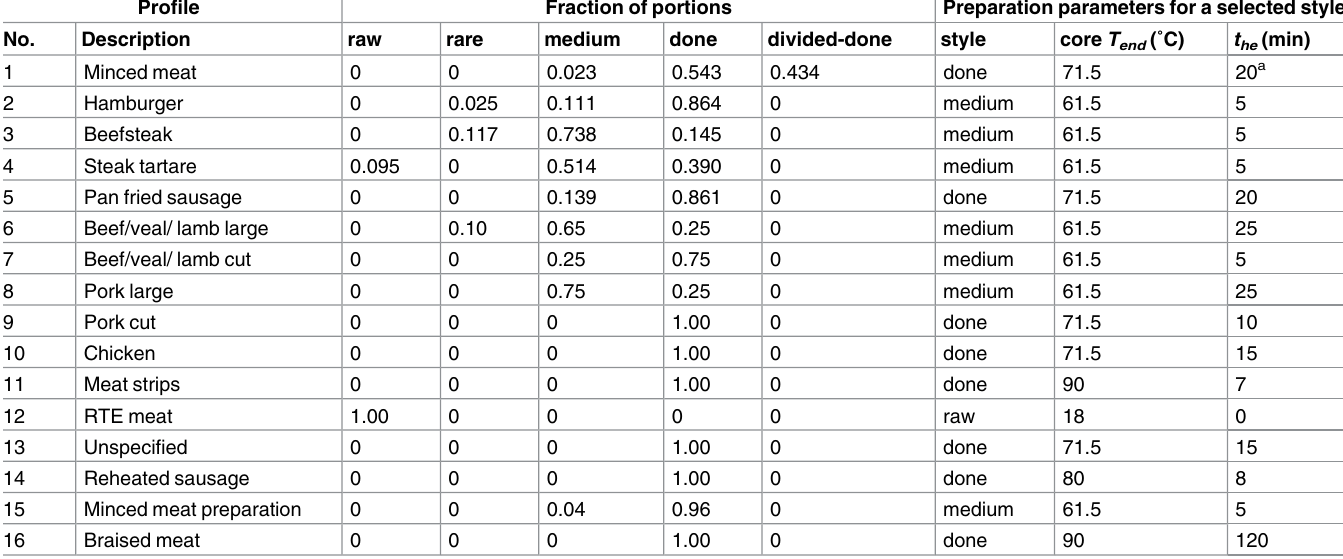
Table 6. Heating profiles for food products at the consumers’